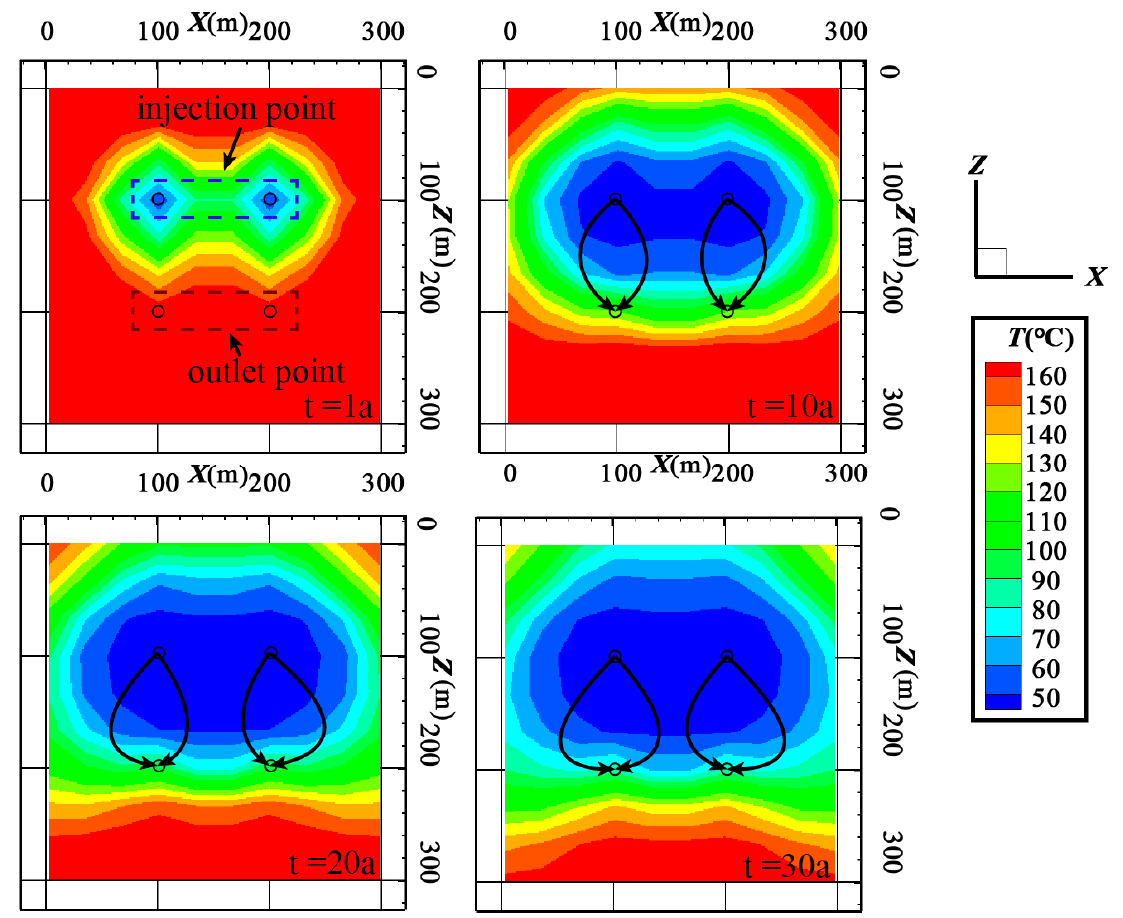
Figure 17. Temperature distribution for the double-pipe heat exchange